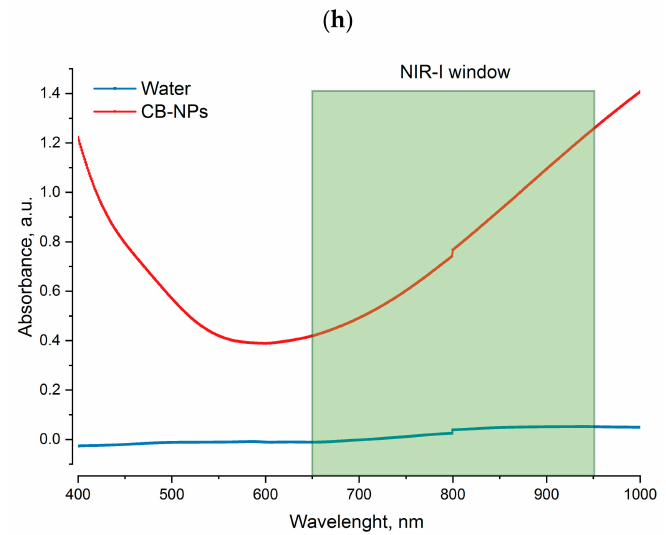
Figure 2. SEM and AFM images of AU nylon nanofibers: ( a ) non-modified (AU) fibers; ( b ) fibers coated with immobilized TNPs (AU-Coat); ( c ) fibers with incorporated nanoparticles TNPs (AU-In). Scale bar –1 µ m. SEM image of the CuS-BSA TNPs ( d ). SEM/EDS image ( e ) and the elemental map reconstructions ( f , g ) of AU-In scaffold. UV-vis-NIR absorption spectrum of the CB NPs ( h ). First NIR window marked in green.